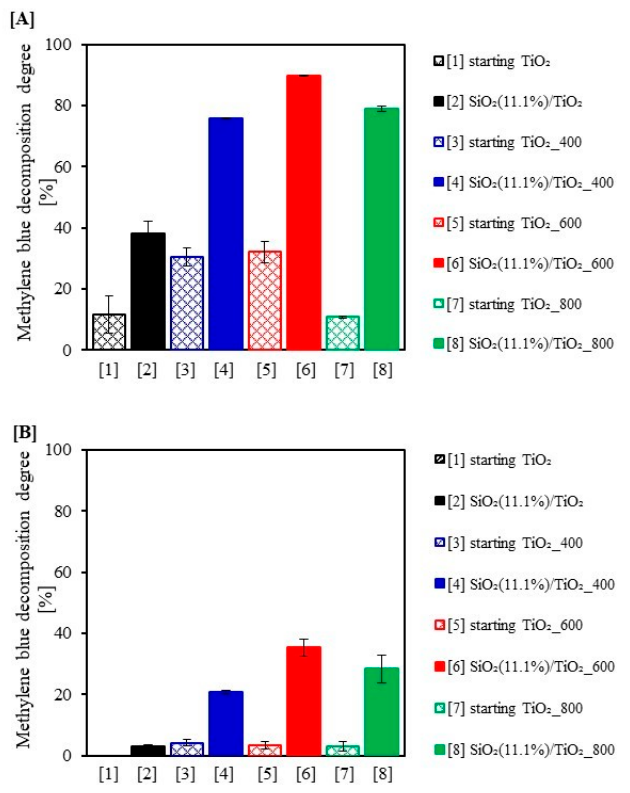
Figure 8. Degree of methylene blue decomposition after 5 h of irradiation under UV-VIS ( A ) and VIS ( B ). Process conditions: C MB = 10 mg/L, V s = 0.5 L, C photocat. = 0.2 g/L, adsorption time—1 h.